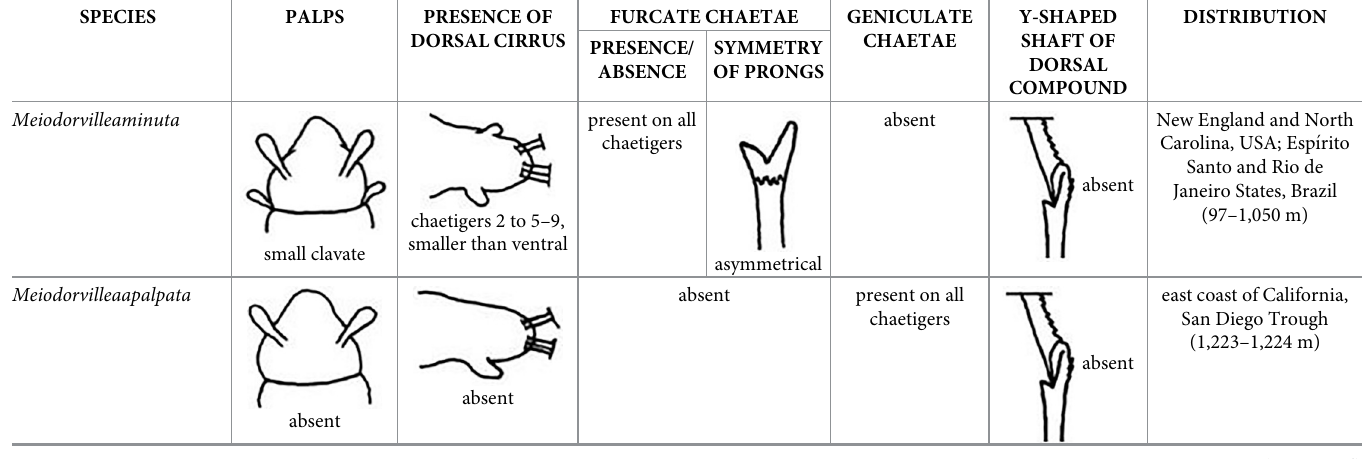
Table 1. Main morphological differences and distribution of Meiodorvillea